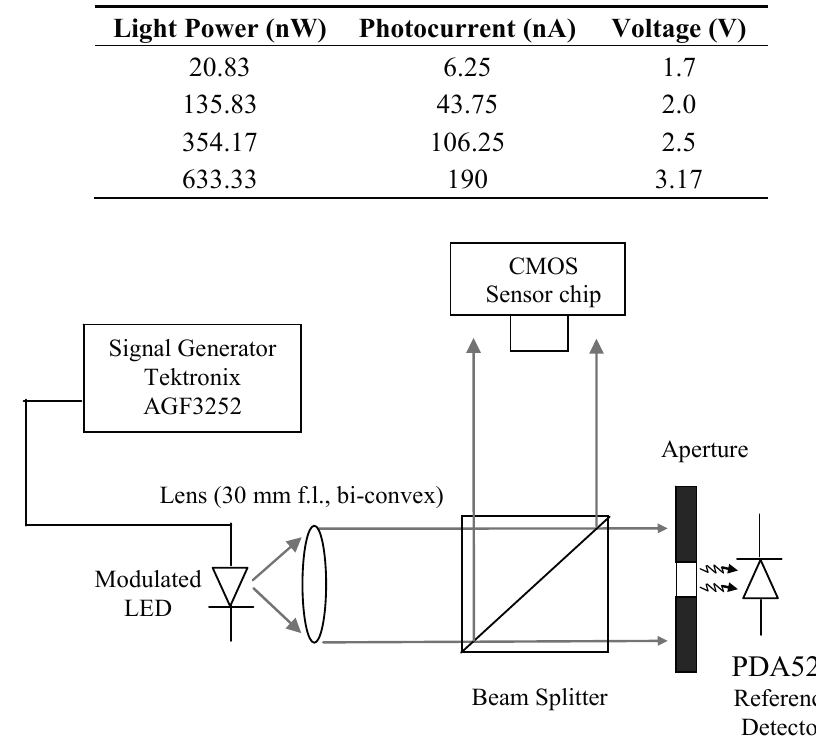
Table 1. Table illustrating the photodiode illuminance, corresponding photocurrent and resulting transimpedance (I/V) amplifier output voltage. Note: the output voltage for dark current is 1.65 V.